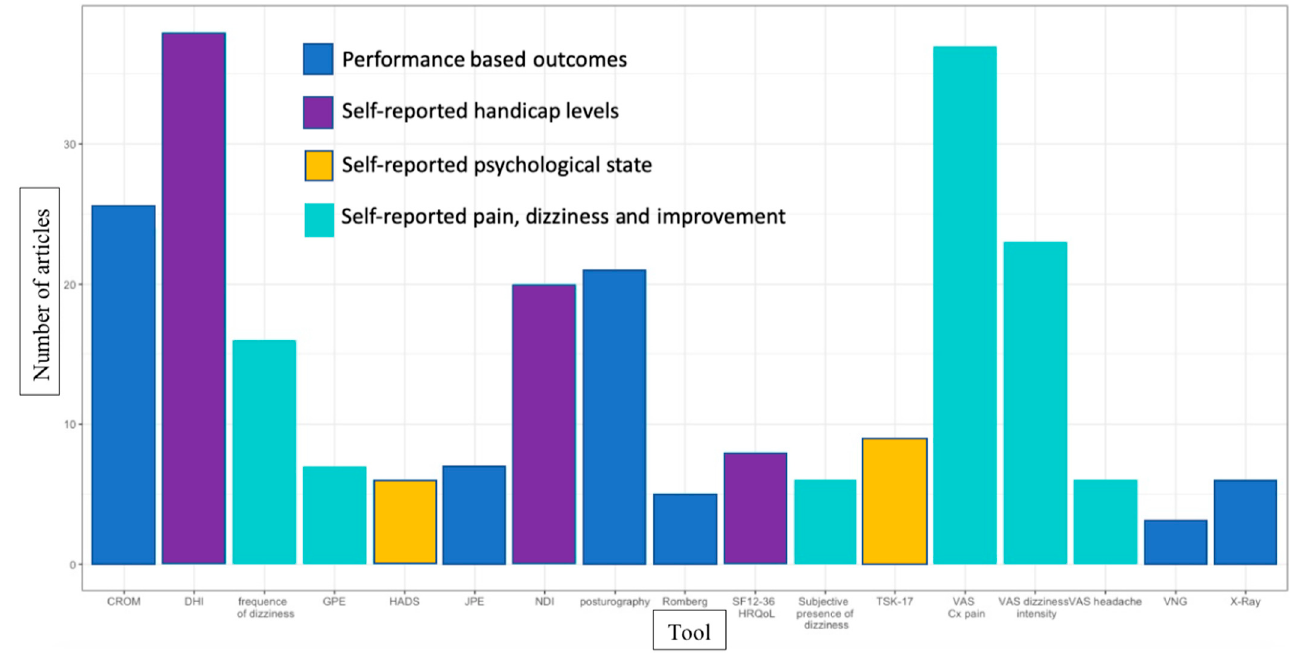
Figure 8. Tools to measure change CROM: cervical range of motion, DHI: dizziness handicap inventory, GPE: global perceived effect, VNG: videonystagmography, HADS: Hospital Anxiety and Depression Scale, JPE: joint position error test, NDI: neck disability index, HRQoL: health-related quality of life, TSK: Tampa Scale for Kinesiophobia, VAS: visual analog scale. Table 5. Measures of change used across subpopulations.